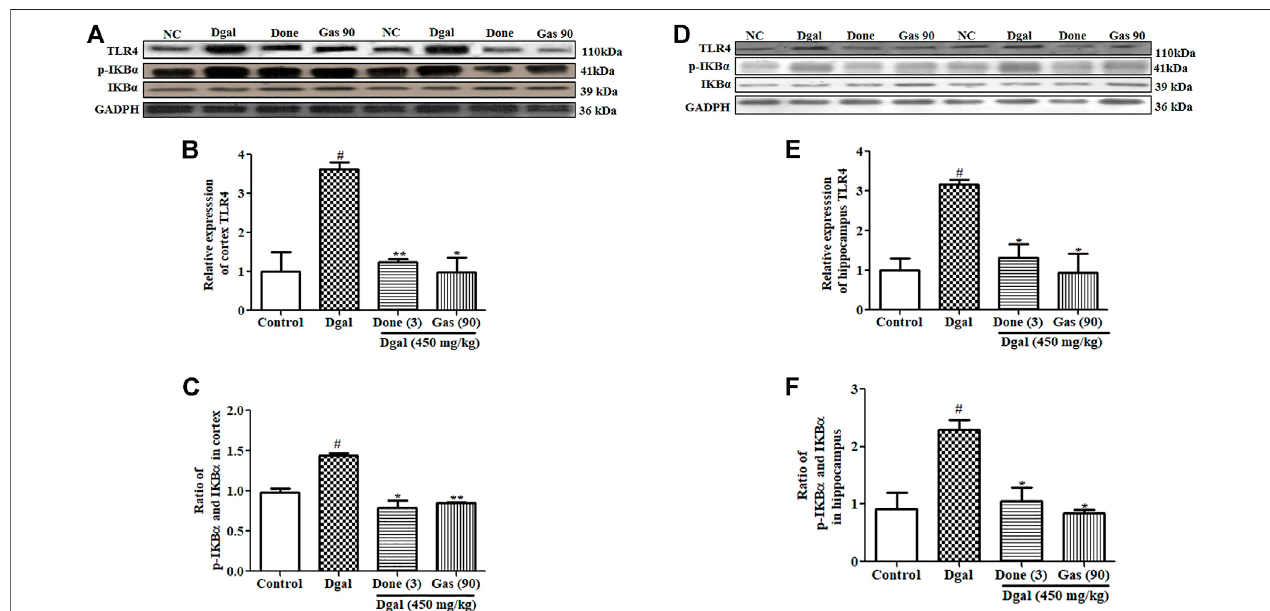
FIGURE 5 | Effect of Gas on the TLR4/NF- κ B signaling pathway in the cerebral cortex and hippocampus. (A) Western blot analysis of the cerebral cortex TLR4, pIKB α , and IKB α . (B) and (C) represent digitalized results of Western blot analysis. (D) Western blot analysis of TLR4, pIKB α , and IKB α in the hippocampus. (E) and (F) represent digitalized Western blot analysis of TLR4, pIKB α , and IKB α in the hippocampus, respectively. Sample number of each group is three, and the data are presentedasmeans ±SEM. # indicates signi fi cantdifferences at p < 0.05 compared withthatin thenormal control; *and** indicatesigni fi cantdifference at p < 0.05 and p < 0.01, respectively, compared with those in the Dgal